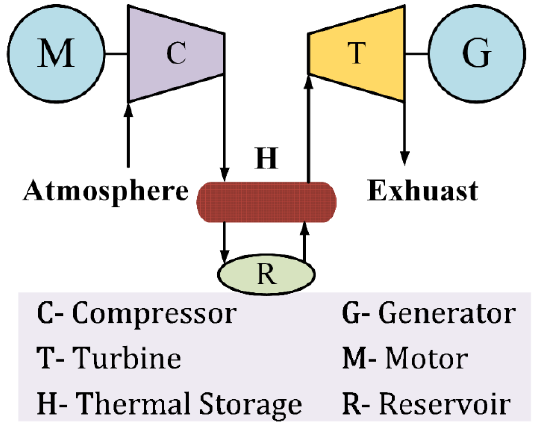
Figure 7. Schematic diagram of advanced adiabatic compressed air energy storage (AA-CAES) system, which is greener than CAES system since it does not release heat into the environment and stores air adiabatically [36].